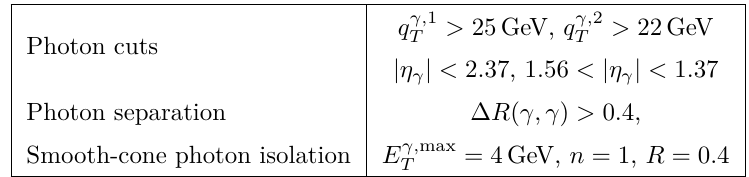
Figure 13. Diphoton invariant mass distribution at NNLO with q γ, 1 further cuts specified in table 4.